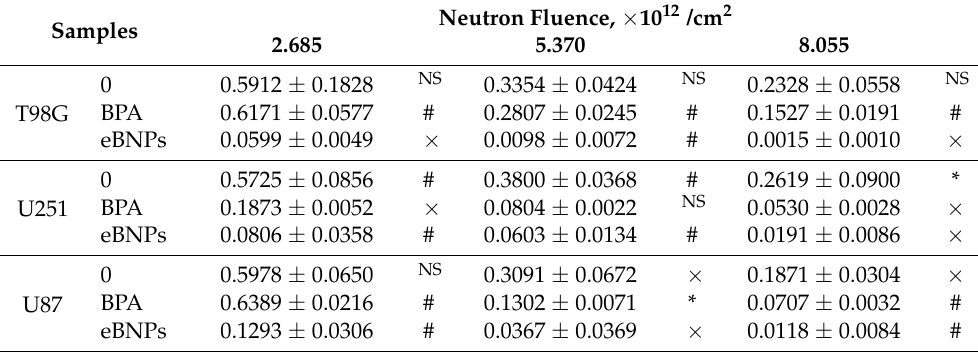
Table 2. Cell surviving fractions (means ±